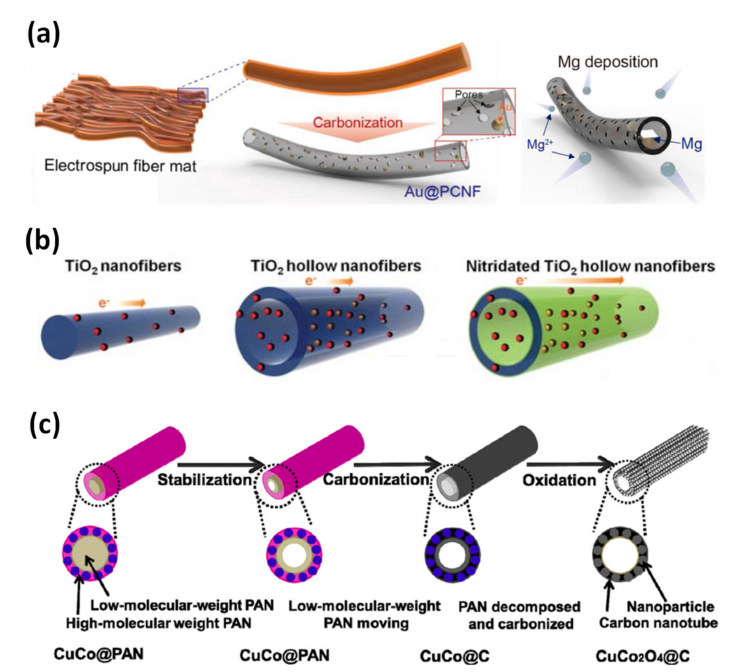
Figure 11. ( a ) Fabrication of hollow porous CNFs decorated with gold nanoparticles on the inner wall [81]. ( b ) Fabrication of TiO 2 nanofibers and TiO 2 hollow nanofibers [82]. ( c ) Fabrication of hollow CNFs containing CuCo 2 O 4 nanoparticles